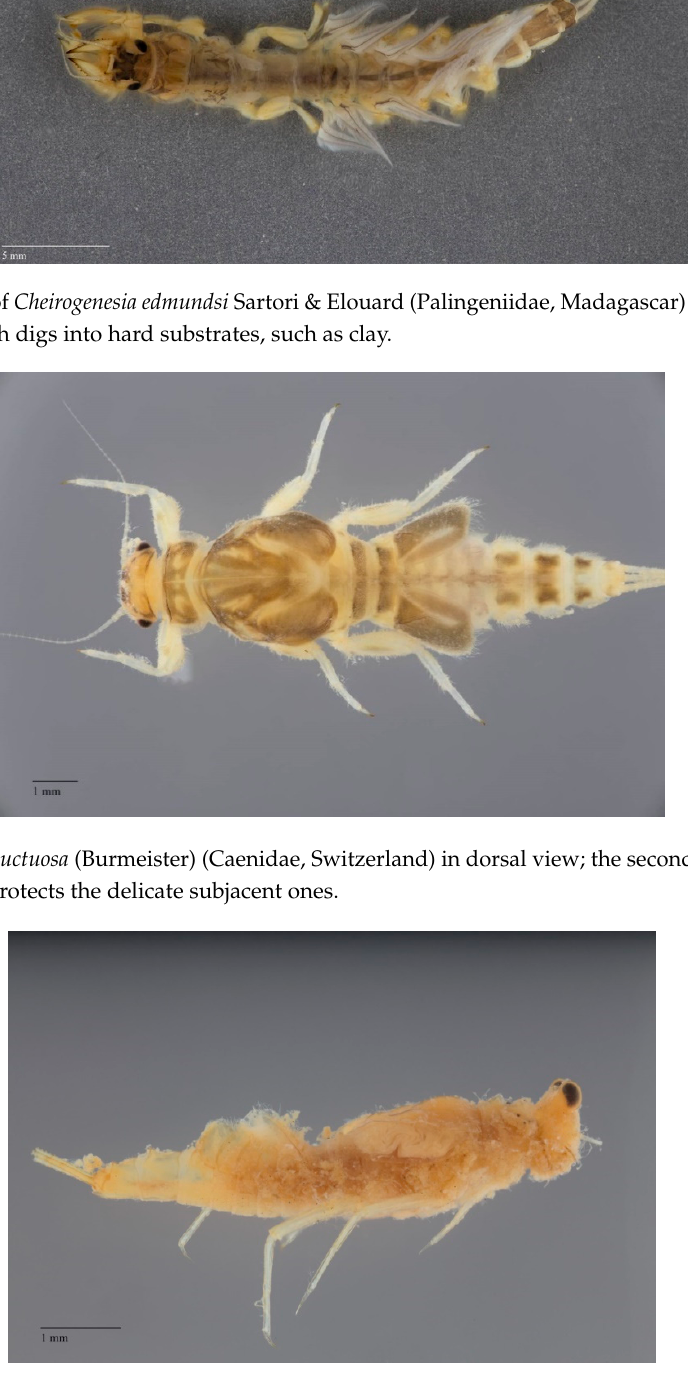
Figure 10. Machadorythus maculatus (Kimmins) (Machadorythidae, Ivory Coast) in lateral view; with middle abdominal segments modified to form a gills basket.